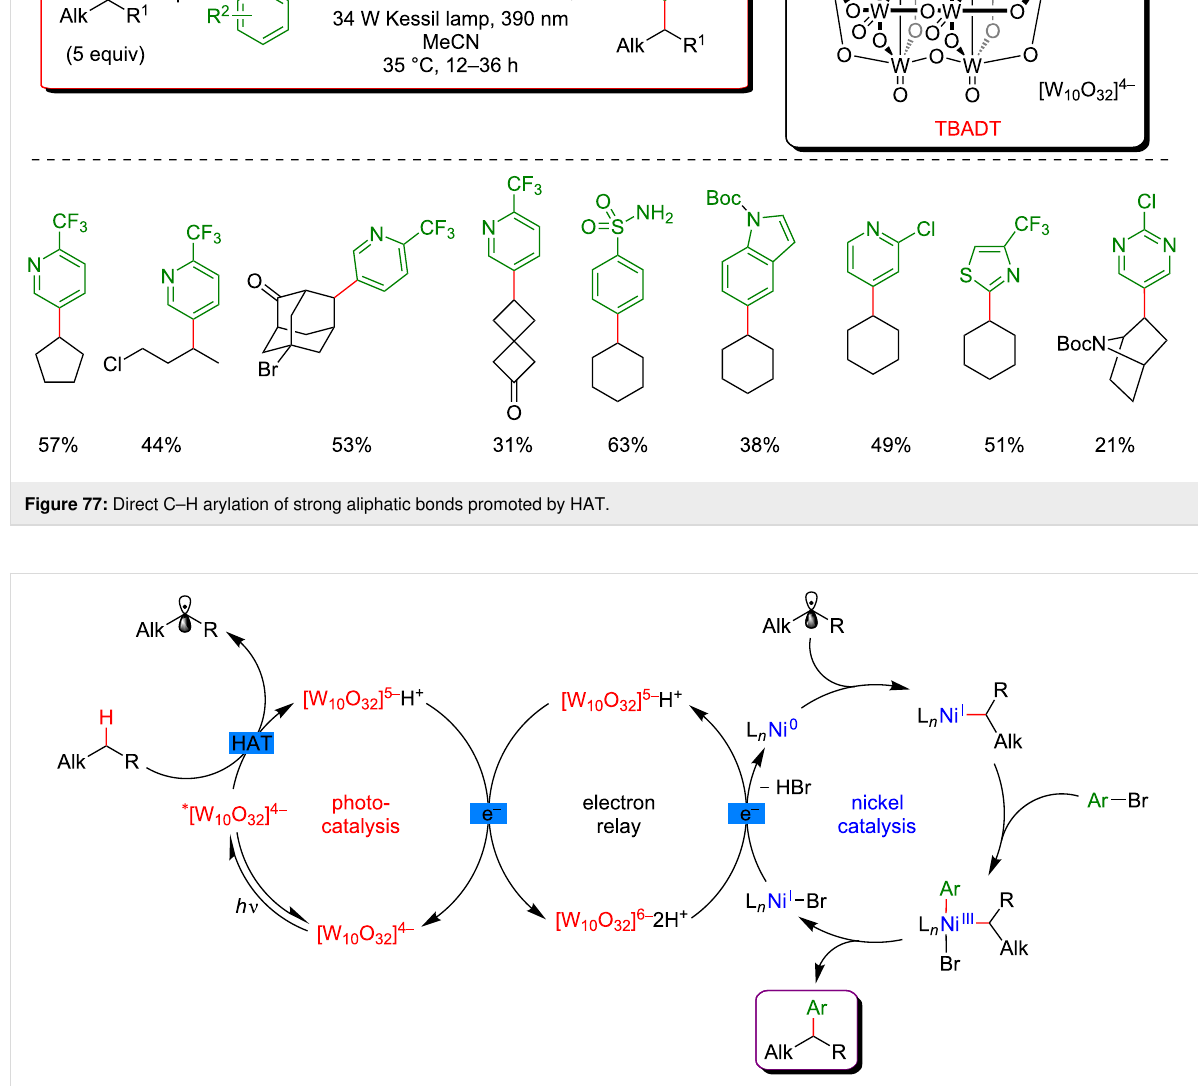
HAT-generated alkyl radial, allow the formation of the key Cu(III)–alkyl–CF 3 intermediate. Upon a reductive elimination step, the trifluoromethylated products were thus obtained (Figure